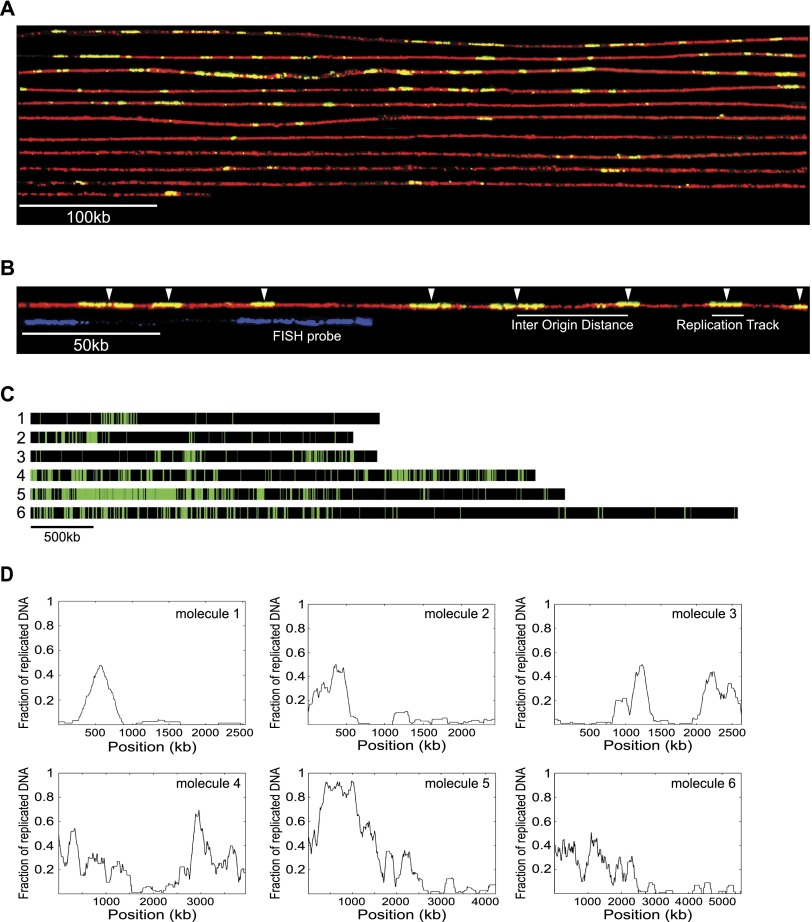
Visualizing DNA replication on single DNA molecules using DNA combing. (A) A single 5.6-Mb molecule that approximately spans the entire length of Chromosome I. To visualize individual BrdU tracks, the molecule was “cut” in silico into 21 consecutive fragments of 270 kb each, and a composite image was constructed. Newly synthesized DNA was labeled in vivo using the halogenated thymidine analog BrdU. Protein-free DNA was combed onto a silanized glass surface and visualized with anti-thymidine antibody (red), and incorporated BrdU was visualized with anti-BrdU antibody (green). BrdU tracks (replication tracks) shown in yellow (green overlaying red) correspond to newly synthesized DNA. (B) White arrows point to the middle of replication tracks (shown with a short white line below the DNA molecule) where we assume replication origins are located. The distance between the middle of two adjacent replication tracks represents the inter-origin distance (IOD) (shown with a longer white line below the DNA molecule). To detect and orient specific DNA sequences on combed DNA molecules, we used fluorescent in situ hybridization (FISH). Each chromosomal position is detected by a unique signature of two probes with differing lengths and distances between them (shown in blue below the DNA molecule), which allowed us to orient the combed DNA molecules and to align them to the corresponding chromosomal region. (C) The distribution of replication tracks on six single DNA molecules randomly selected from the population of molecules. Green bars represent BrdU replication tracks and black bars represent unreplicated segments on DNA molecules. Black and green bars are drawn to scale. All DNA molecules analyzed in this study are represented in Supplemental Figure S15, and the measurements for each molecule are listed in Supplemental Table S2. The DNA molecule shown in A corresponds to molecule 6 in C. (D) Moving average analysis using a 200-kb window size in 2-kb steps (the resolution of the DNA combing technique) of the six molecules shown in C. Each value corresponds to the fraction of replicated DNA within a 200-kb stretch of DNA. Peaks represent chromosomal domains rich in replicated DNA, whereas troughs represent chromosomal domains poor in replicated DNA.